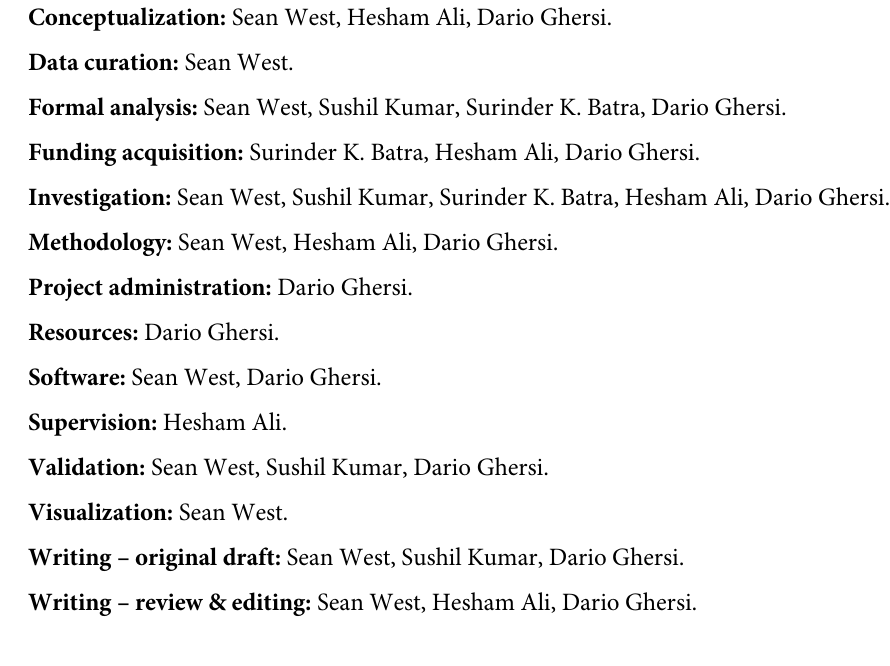
S3 File. List of multi-granularity graphs. This table reports the entire list of MGGs for the TCGA LUAD dataset. The file does not contain the exact paths, only the members of each component of the